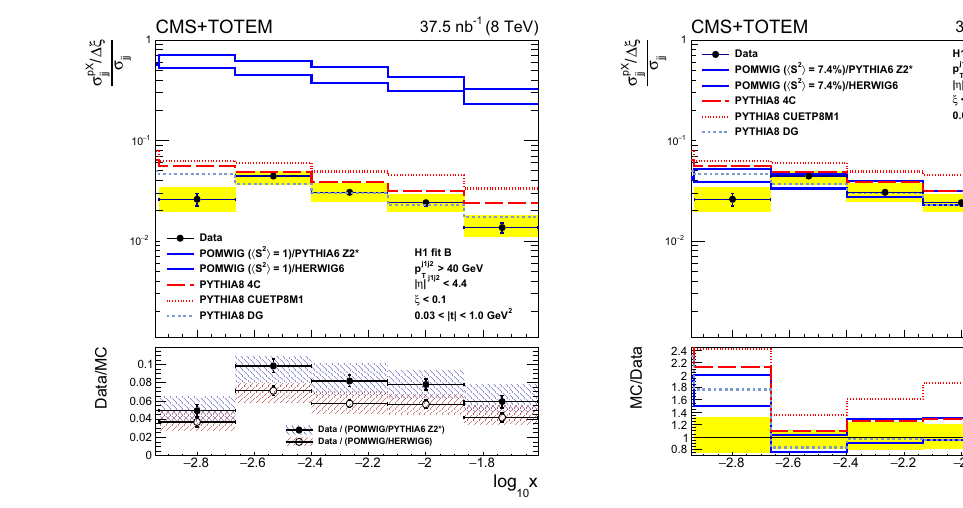
low band indicates the total systematic uncertainty. The average of the results for events in which the proton is detected on either side of the interaction point is shown. The ratio between the data and the pomwig prediction using pythia6 or herwig6 as the nondiffractive contribu- tion, when no correction for the rapidity gap survival probability is applied, is shown in the bottom of the left